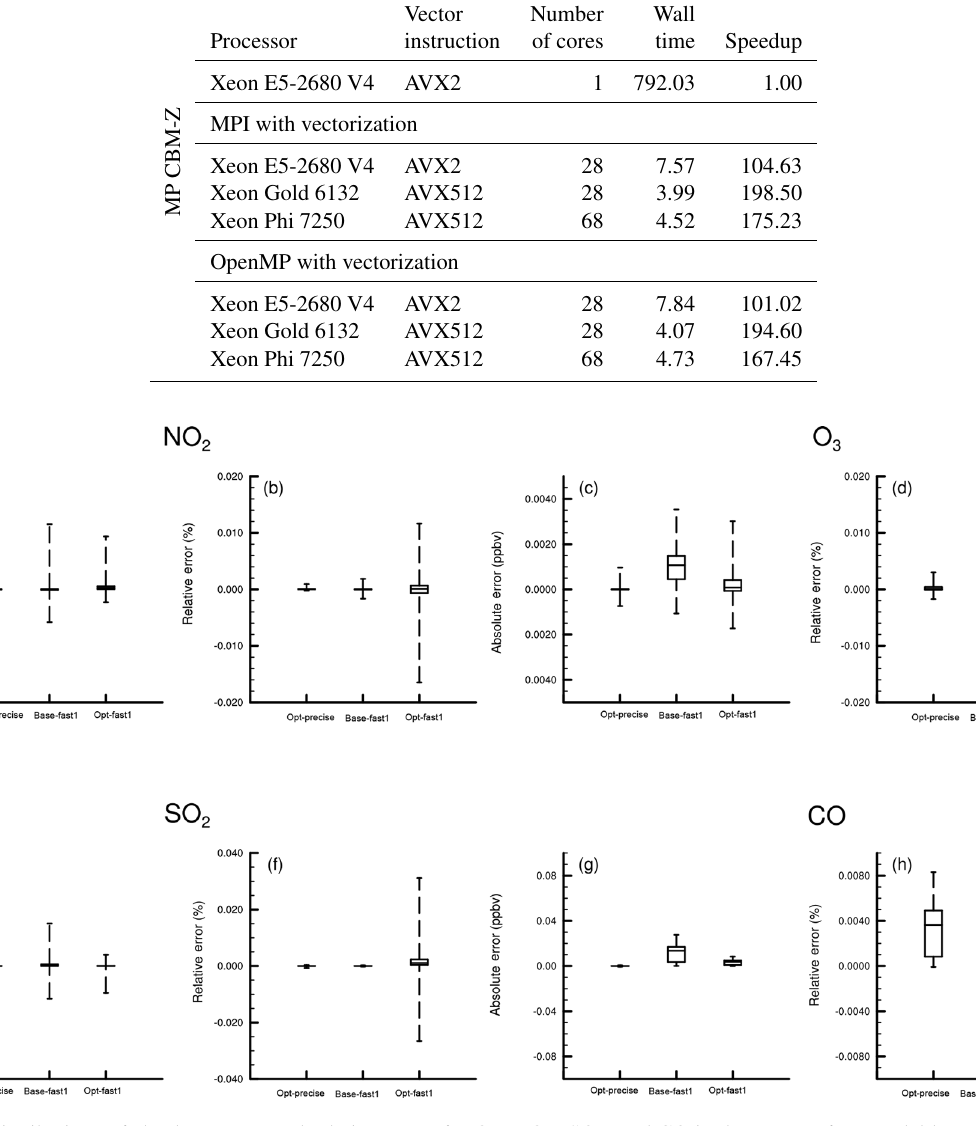
Figure 7. The distributions of absolute errors and relative errors for O 3 , NO 2 , SO 2 , and CO in the near-surface model layer. The reference points are 1%, 25%, 50%, 75%, and